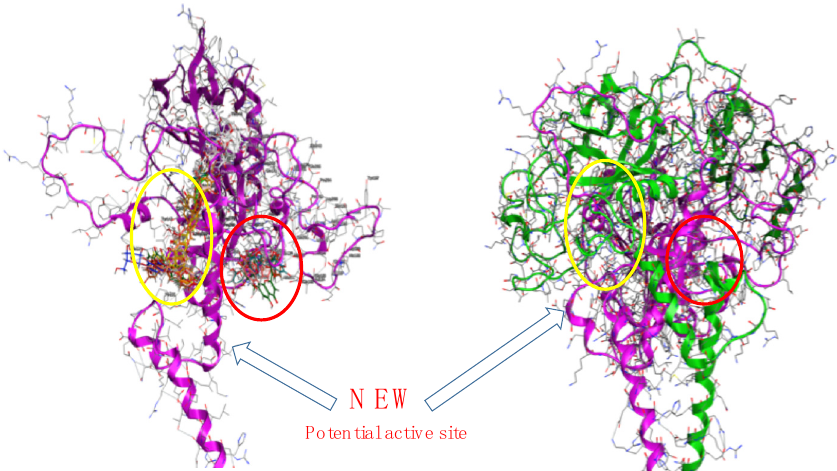
Figure 3. Interaction of flavonoids at the interface of the bHLH and PAS-A domains of AHR modeled by SwissModel. bHLH-PAS-A (yellow) and PAS-A (red).